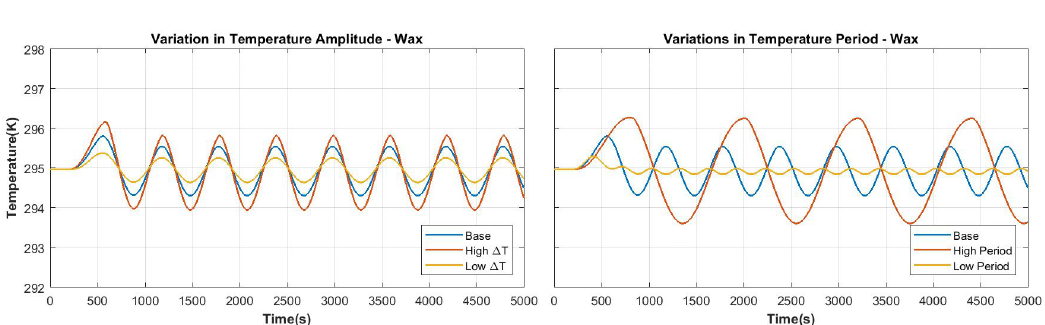
Figure 14. Results of paraffin wax at Re = 1000 with amplitudes of 10, 20, 30 K and periods of 5, 10, 20 min. When the temperature oscillations increase the PCM becomes slightly active which results in slightly lower peak temperature. In the case of variations in period, longer periods did not result in phase change of the material thus more heat diffused through the material due to the longer period at a high temperature in a fashion similar to the myristic